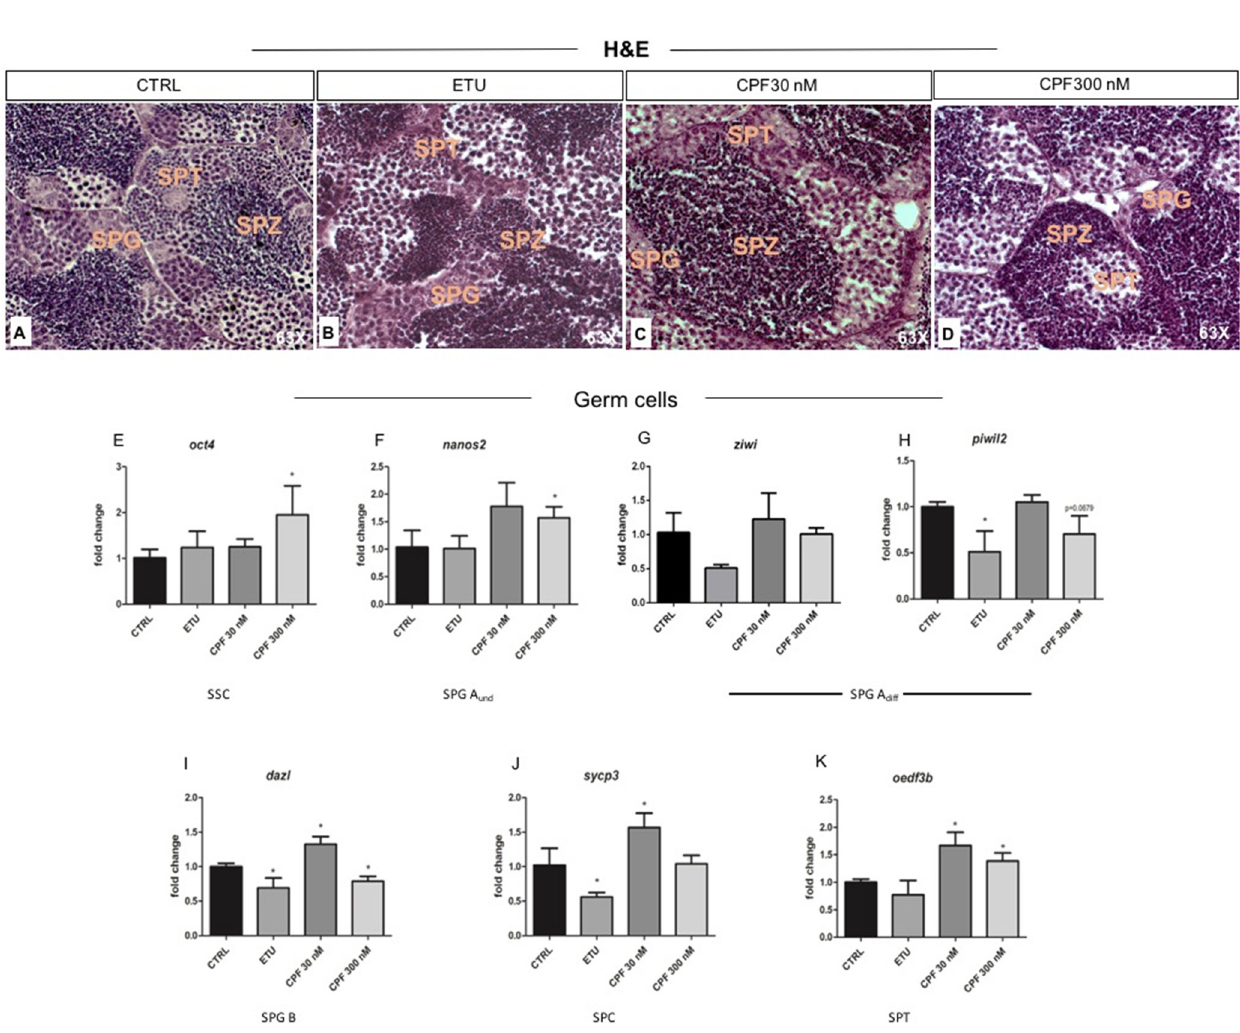
Figure 8. Analysis of testis morphology and molecular markers of spermatogenesis in zebrafish developmentally and long life exposed to CPF and ETU. ( A – D ) Hematoxylin and Eosin staining of zebrafish testes sections from adult animals exposed to pesticides and not exposed (CTRL) (63× magnification). The different germ cells sub-population are evidenced. RT-qPCR analyses of the expression profiles of different germ cells markers: starting from stem cell/undifferentiated spermatogonia ( oct4 , nanos2 ) ( E , F ), differentiated spermatogonia type A and B ( ziwi , piwil2 , dazl ) ( G – I ), and differentiated spermatocytes and spermatids ( sycp3 , oedf3b ) ( J , K ). RT-qPCR analyses were performed on dissected zebrafish adult testes (N° = 3 testis/group). Data analysis was conducted as described in M&M section. Data are reported as fold change values calculated as a ratio between average relative gene expression in treated and control, after normalization on β -actin mRNA. Mean and standard deviation are reported. Significant difference from the control group is indicated by * p < 0.05. One-way ANOVA (post hoc test: Dunnett’s) was used. SSC = spermatogonial stem cell; SPG = spermatogonia; SPG A und = undifferentiated spermatogonia type A; SPG A diff = differentiated spermatogonia type A; SPG B = spermatogonia type B; SPC = spermatocyte; SPT = spermatids; SPZ = spermatozoa.